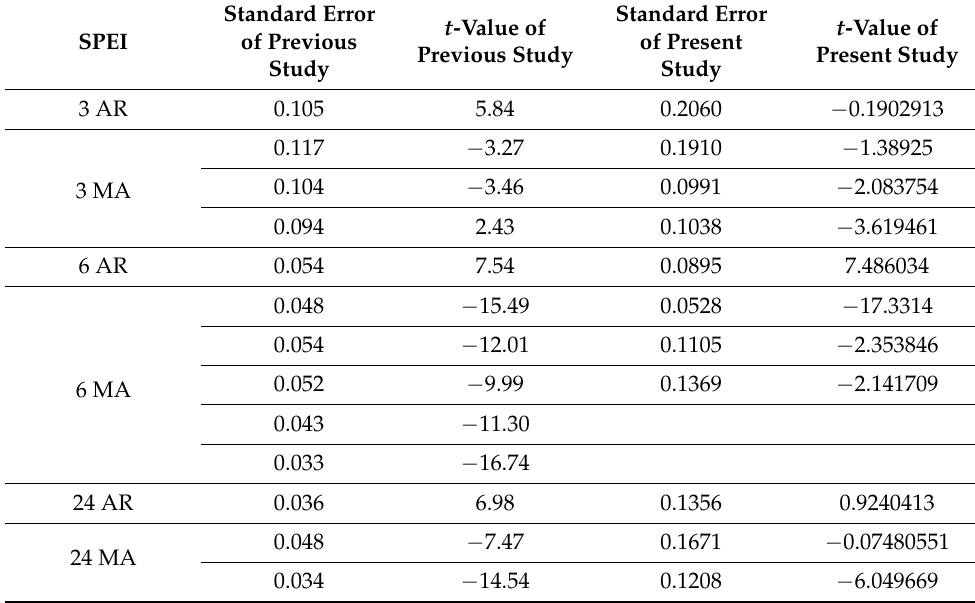
Table 20. A comparison of the present and previous study